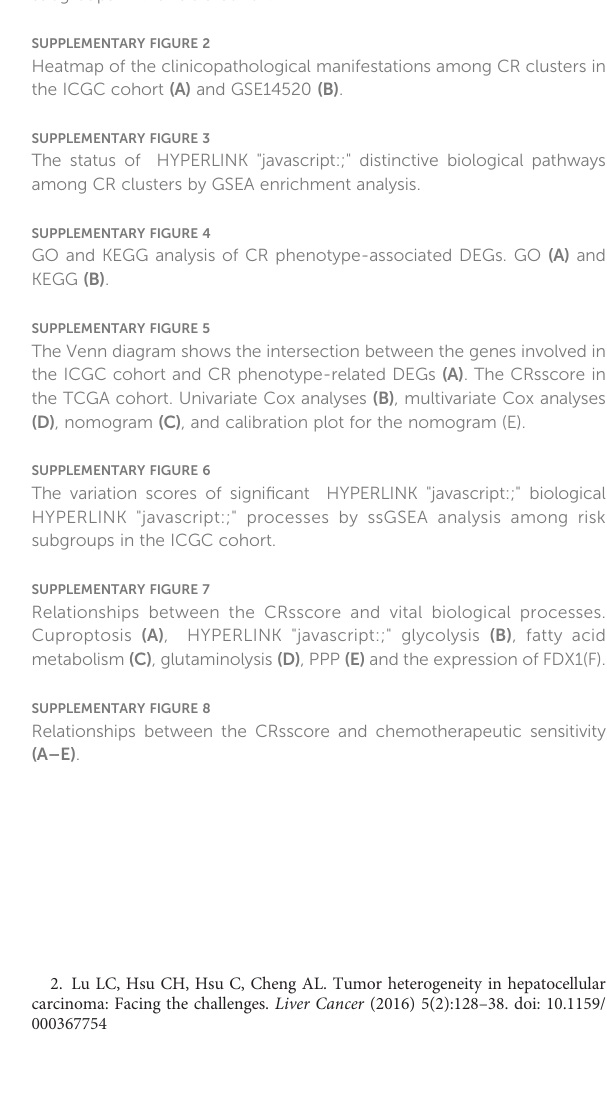
SUPPLEMENTARY FIGURE 2 Heatmap of the clinicopathological manifestations among CR clusters in the ICGC cohort (A) and GSE14520 (B) . SUPPLEMENTARY FIGURE 3 The status of HYPERLINK "javascript:;" distinctive biological pathways among CR clusters by GSEA enrichment analysis. SUPPLEMENTARY FIGURE 4 GO and KEGG analysis of CR phenotype-associated DEGs. GO (A) and KEGG (B) .